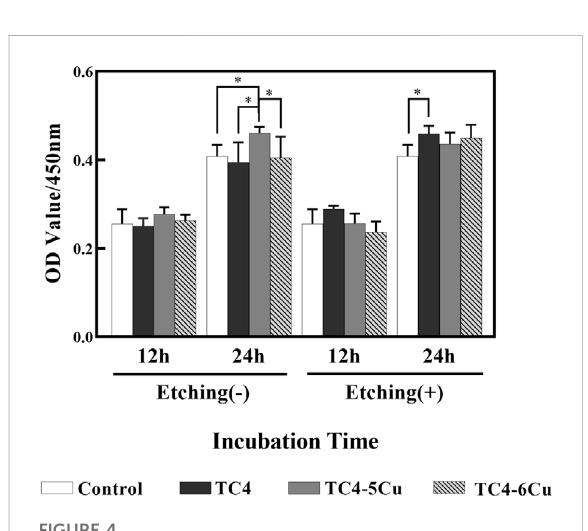
FIGURE 4 CellproliferationofRAW264.7cellsculturedindifferentalloy extracts for 12 and 24 h ( n = 5, * p < 0.05)